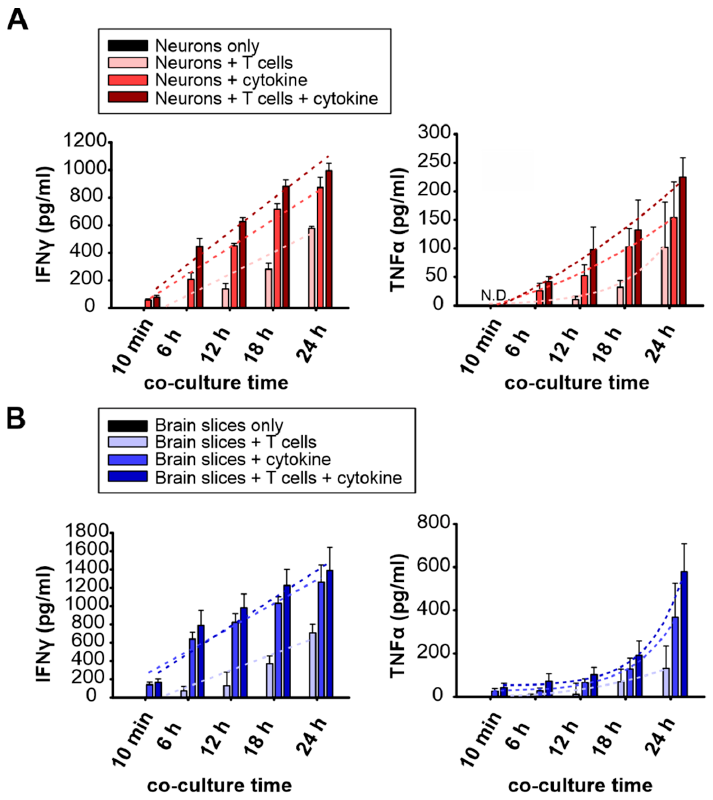
Figure 4. Proinflammatory cytokine release in neuronal culture and brain slices during T cell co- culture. Culture media were collected from ( A ) in vitro T cell–neuron co-culture or ( B ) ex vivo T cell–brain slice co-culture after 10 min, 6 h, 12 h, 18 h, and 24 h. IFN γ data were linearly fit. TNF α data were fit with an exponential growth function (stipple lines). Released IFN γ or TNF α from the different culture conditions were measured by ELISA. ELISA measurements were performed from four independent preparations, with one technical replicate from each preparation. N.D.